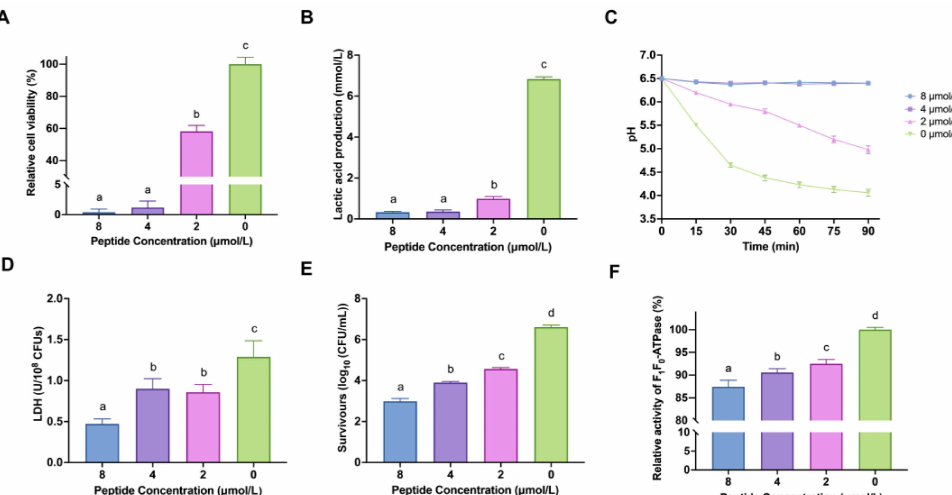
Figure 1. The inhibition of LF-1 on the growth, acid production, and acid tolerance of planktonic Streptococcus mutans . The relative cell viability of S. mutans under LF-1 treatment within 6 h was evaluated using the MTT method. ( A ) The acid production capacity of S. mutans under the LF-1 treatment is determined by measuring lactic acid production ( B ), glycolytic pH drop ( C ), and LDH activity. ( D ) The acid tolerance capacity of S. mutans under the LF-1 treatment is evaluated by counting survivors in the lethal acidic environment ( E ) and measuring the relative F 1 F 0 -ATPase activity. ( F ) All data are presented as the mean ± standard deviation from at least three independent experiments, and relative values are obtained by comparison with the untreated control. Columns labelled with different superscript letters denote significant statistical differences in one group (one-way analysis of variance; p < 0.05). MTT: methyl thiazolyl tetrazolium; LDH: lactate